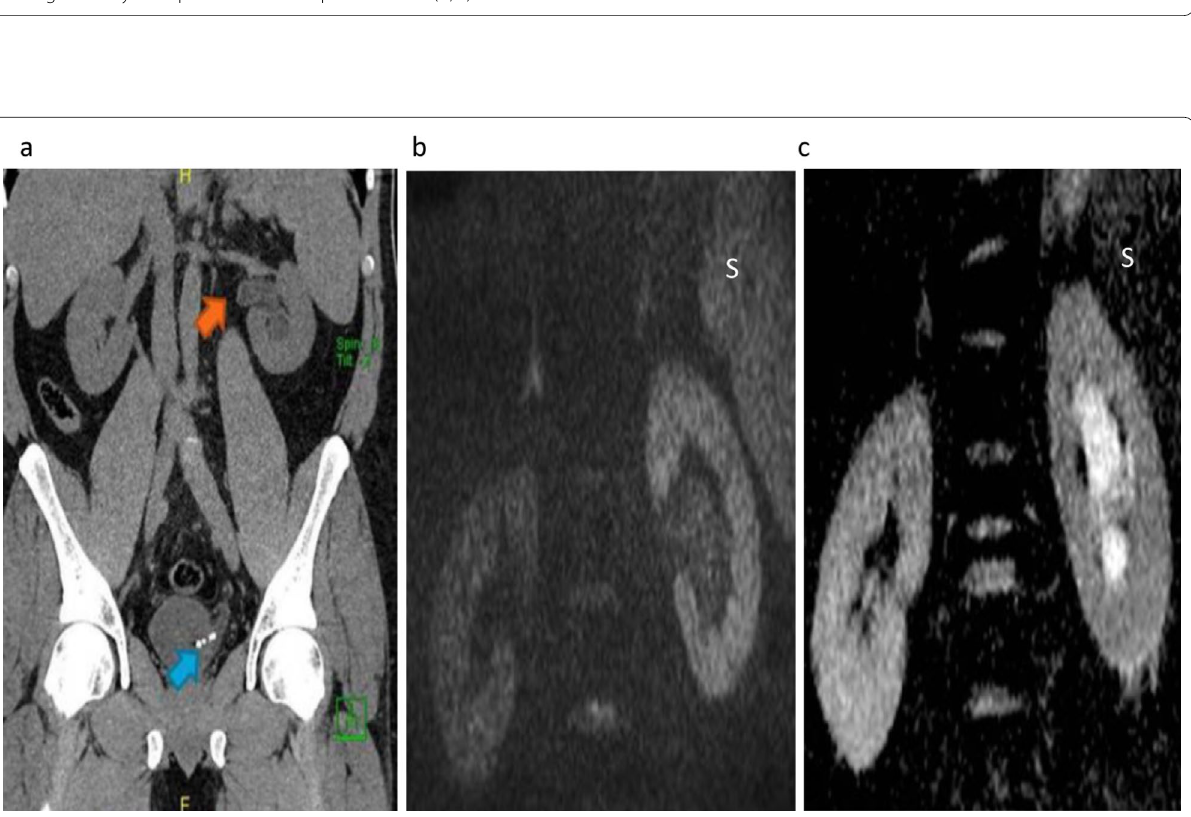
Fig. 2 A 32-year-old male patient presented with left renal colic, Coronal reformatted CT ( a ), shows left hydronephrosis due to stone [not shown] along the course of the left pelvic ureter, Diffusion image ( b ), demonstrating diffuse high signal of the left kidney compared with contralateral right kidney and almost equal to the spleen. ADC map ( c ) shows a reduction of the signal intensity at the left kidney with hydronephrosis compared with the right kidney and spleen. S refers to spleen at both ( b , c )